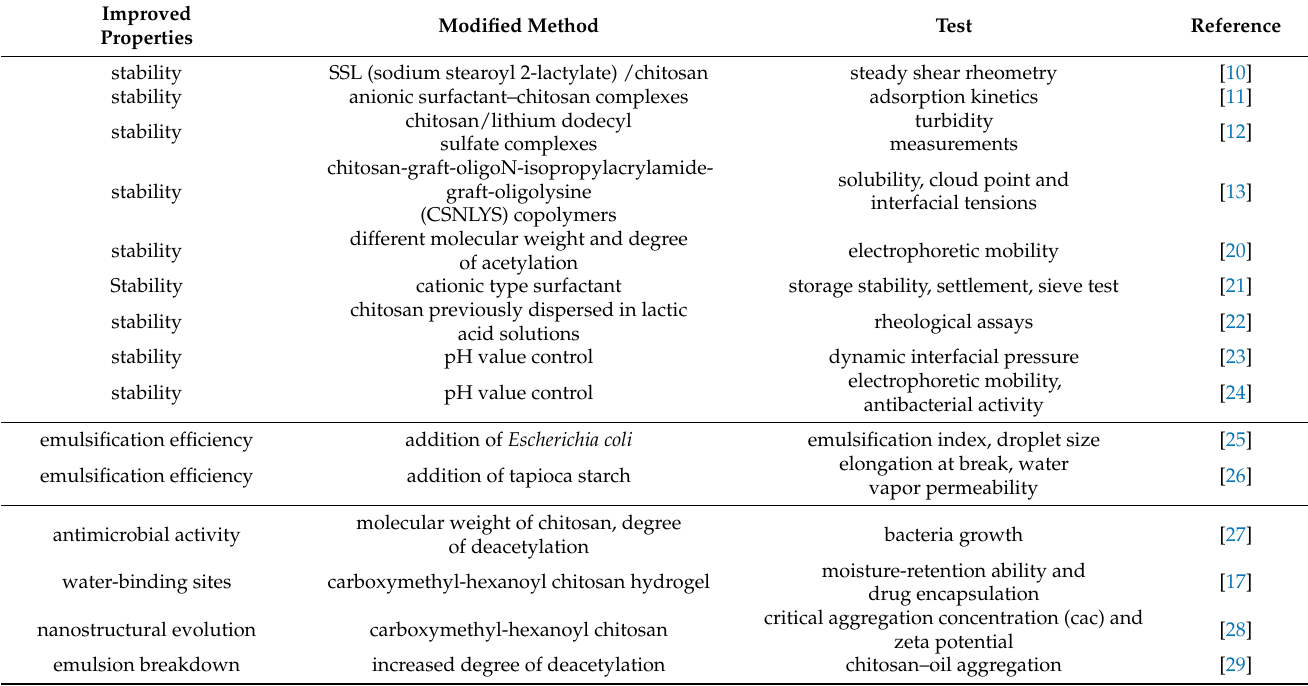
Table 1. Some studies associated with chitosan molecule used in emulsification and characteriza- tion